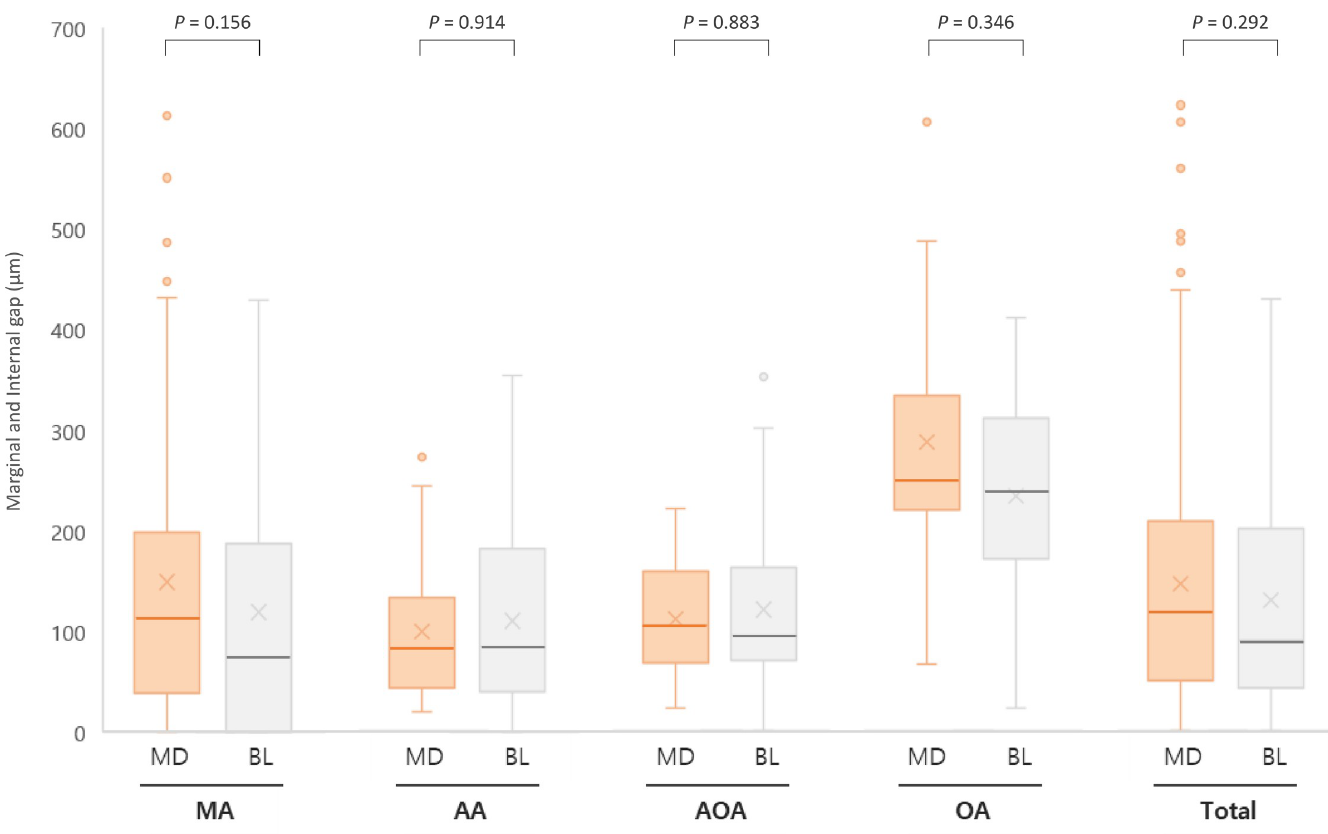
Fig 13. Comparison of the marginal gap and internal gap between mesiodistal and buccolingual surfaces. MD: mesiodistal; BL: buccolingual; MA: marginal area; AA: axial area; AOA: axio-occlusal angle; OA: occlusal area. P-values were obtained using the Mann-Whitney U test.